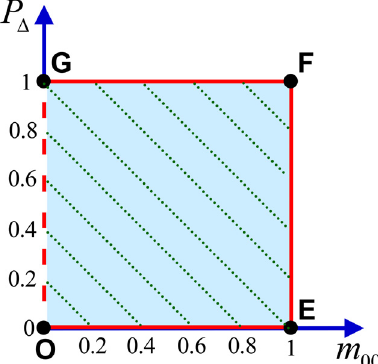
Figure 1. The feasible region for the degree of reversibility, P R , is determined by the regular square OEFG, edge OG excluded. Edges OE (point O excluded), EF, and FG correspond, respectively, to perfect depolarizers, transparent media, and nondepolarizing media. Point F corresponds to transparent retarders, while point E corresponds to transparent perfect depolarizers. Iso-reversibility lines are represented by the dashed segments.